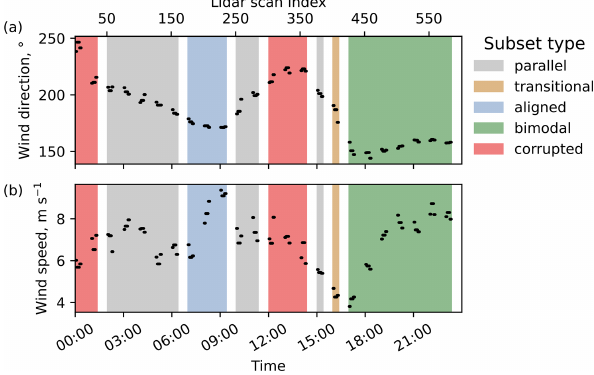
Figure 7. Classification of the subsets and overview of the refer- ence wind direction (a) and wind speed (b)